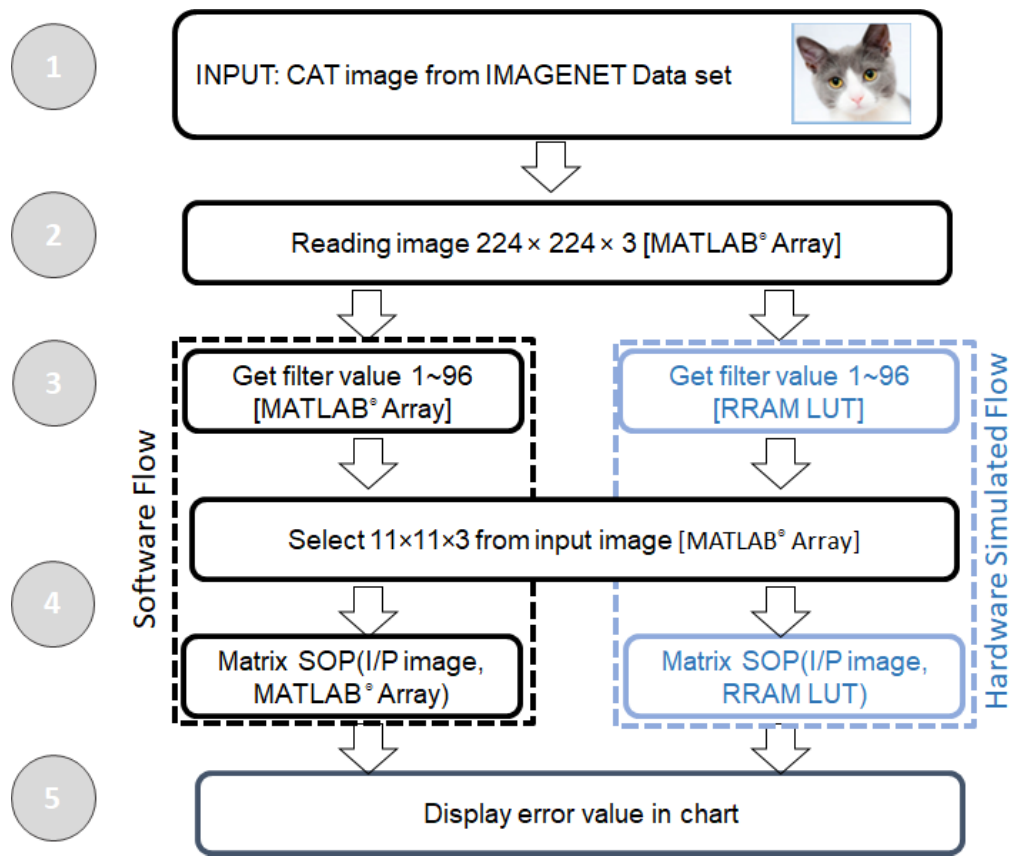
Figure 6. Flowchart showing the implementation of resistive random access memory (RRAM) based look-up table (LUT) for error quantification of a hardware implementation of the CNN using the AlexNet schema with Layer 1 being the convolution layer where the LUT is incorporated.